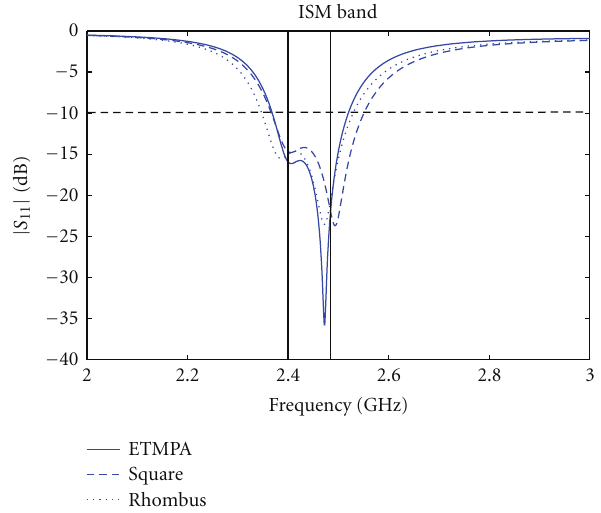
Figure 5: Simulated reflection coe ffi cients of one port of the ULA array: tip-truncated ETMPA (full line), square ring patch (dashed line), and rhomboidal ring patch (dotted and dashed line).